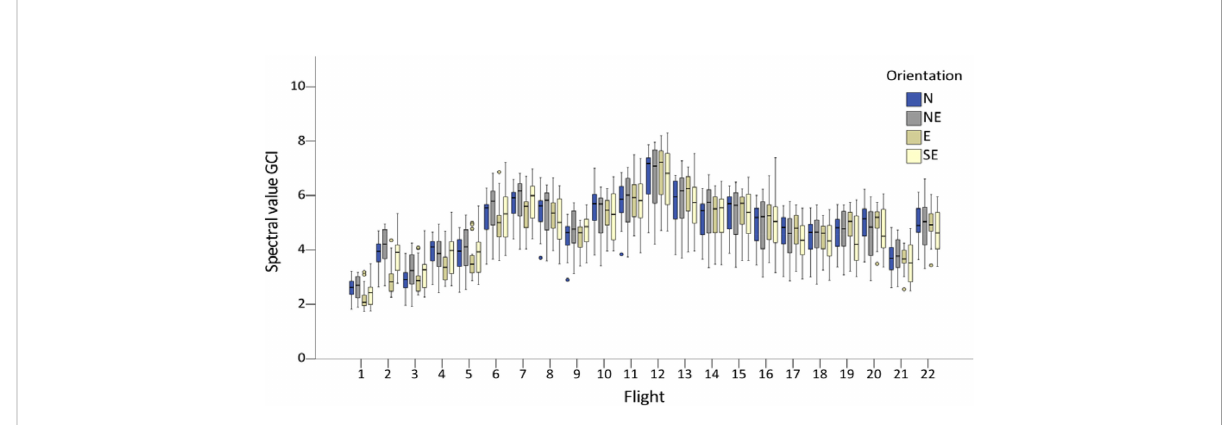
FIGURE 6 Boxplots of GCI values for each fl ight and row orientation (N = north, NE = northeast, E = east, SE = southeast). The boxes indicate repeated spectral measurements within the growth stages BBCH 17, 61, and